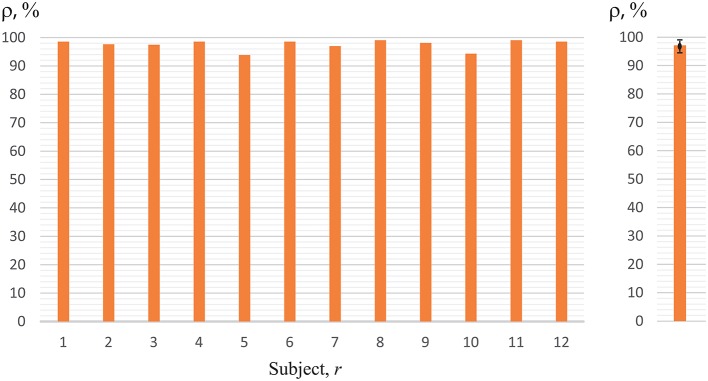
Recognition accuracy using ANN trained on subject 4 (h = 4) for all of the 12 subjects. The right panel represents the data averaged over all subjects under study.